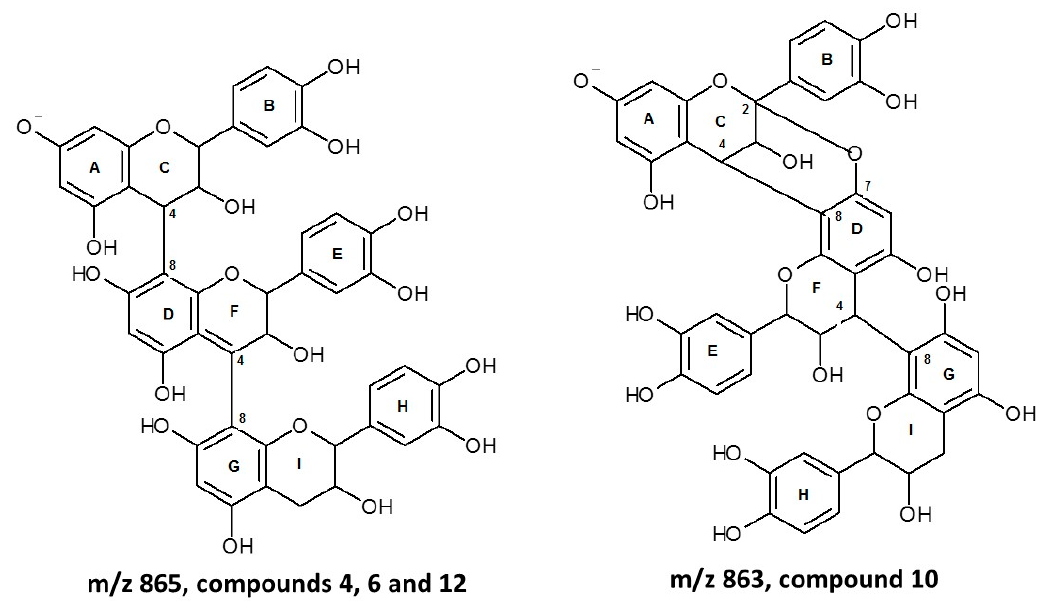
Figure 4. Type A and type B procyanidin trimers identified in Persea americana Mill. Nariño cultivar.